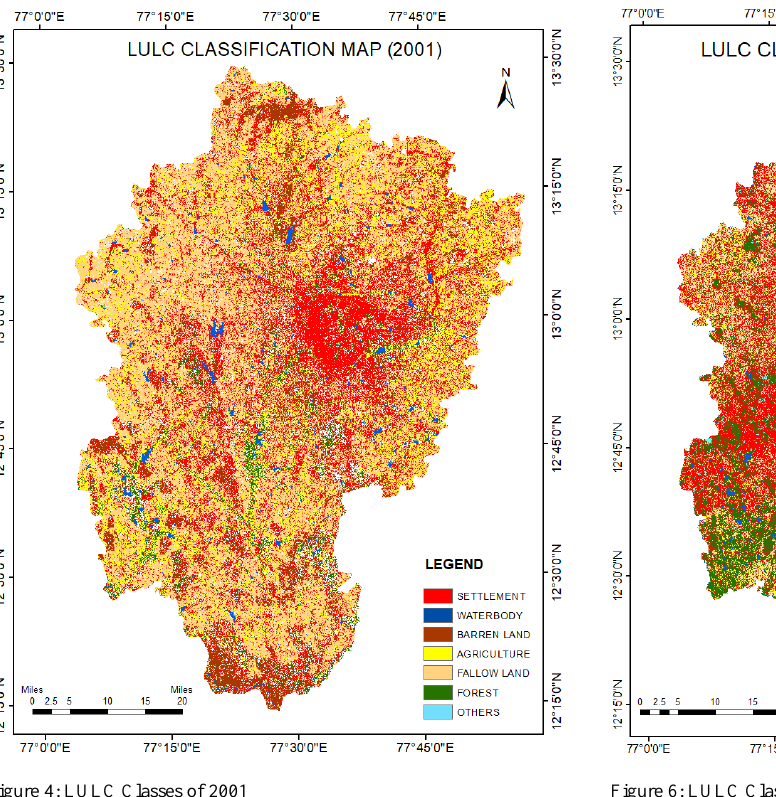
Figure 7 clearly shows the areas under different land use classes in percentage between 1981-2050. The chart depicts less settlements development in 1981 (5.9%), whereas in 2050, it shows 59.9%, the predicted settlement expansion ten times than 1981 settlement area coverage. Similarly, wasteland areas are decreasing from 1981 (62%) to 2050 (2.5%). This shows that in settlement plots, commercial and industrial activity or other